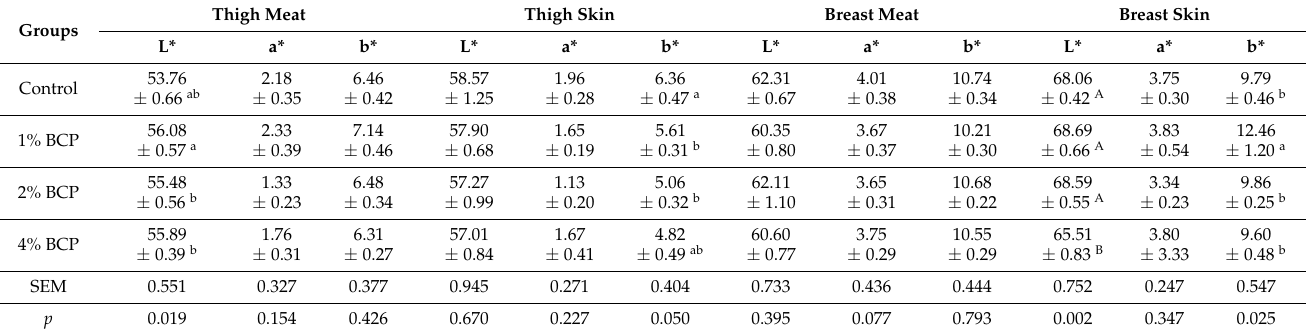
Table 7. The effect of the different levels of BCP supplementation on the thigh meat, thigh skin, breast meat, and breast skin in cold